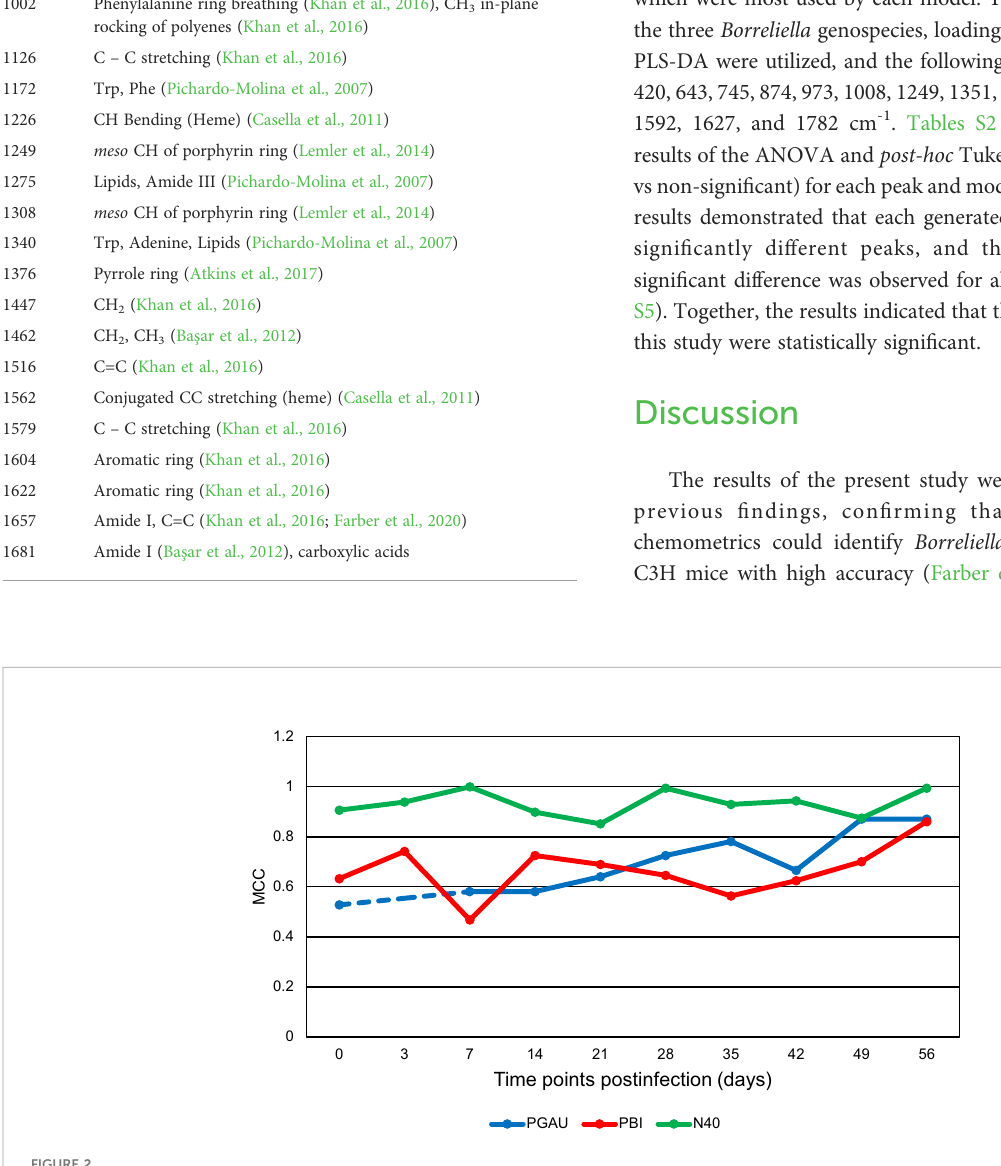
FIGURE 2 The Matthew ’ s Correlation Coef fi cient (MCC) for the binary model comparing the uninfected control to each of the three Borreliella genospecies over time. Mouse blood was sampled from C3H mice prior to their infection and postinfection with B afzelii PGau (PGAU), B garinii PBi (PBI), or B burgdorferi N40 (N40). The blood was also collected from age- and sex-matched uninfected (control) C3H mice. The dashed line indicates that the data are